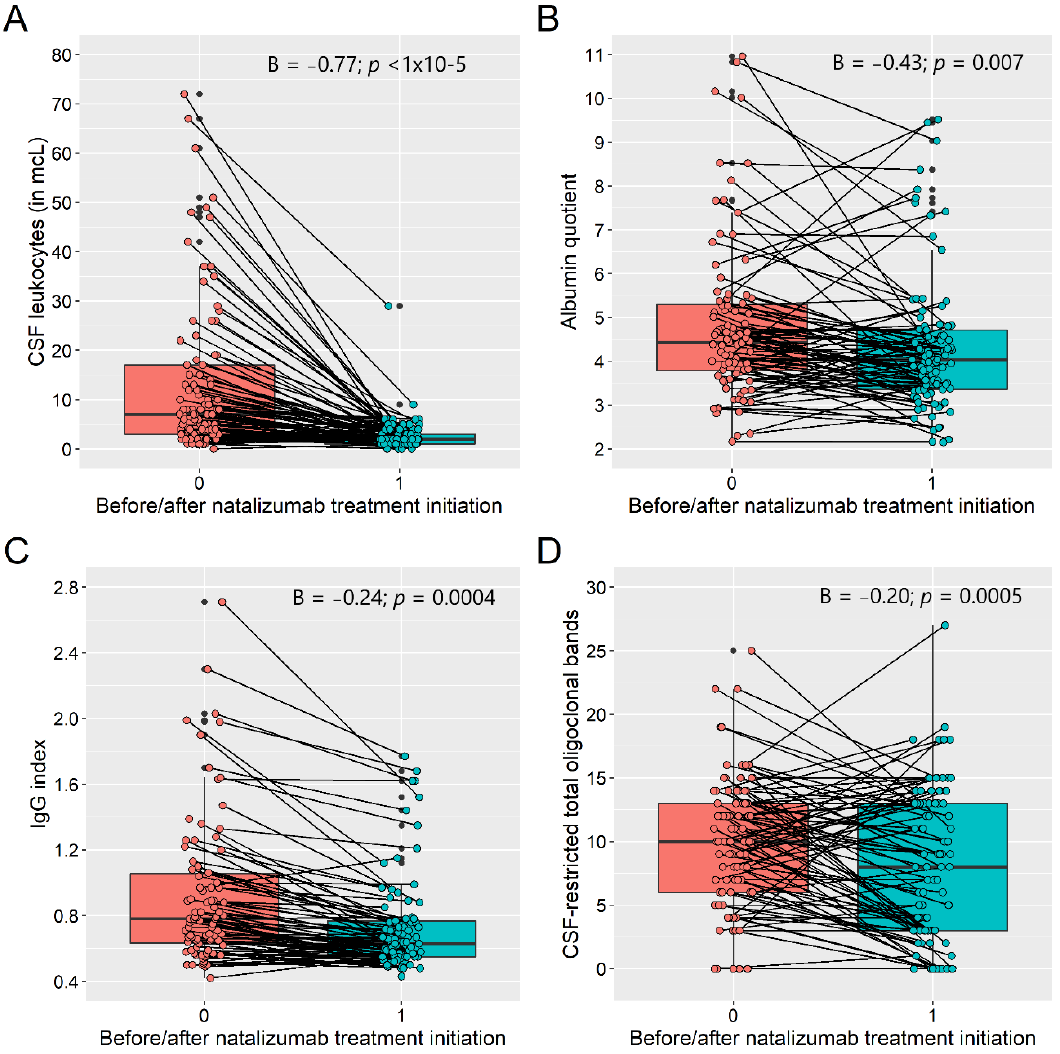
Figure 3. Natalizumab − induced changes of CSF leukocytes ( A ); albumin quotient ( B ); IgG index ( C ); and CSF-restricted oligoclonal bands ( D ).